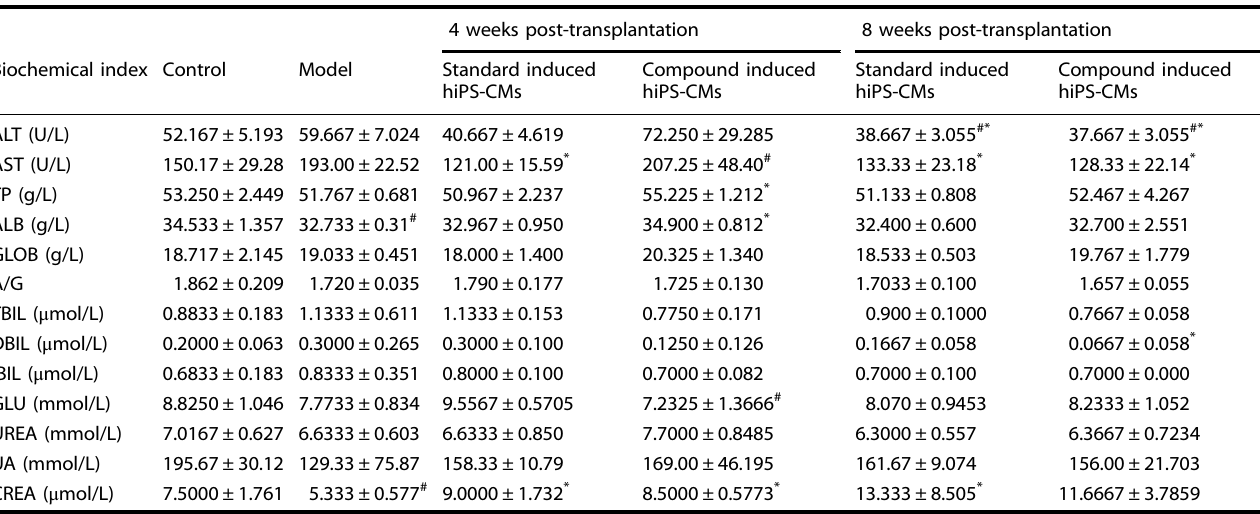
Table 1. Biochemical safety index detection post-transplantation 4 weeks post-transplantation 8 weeks